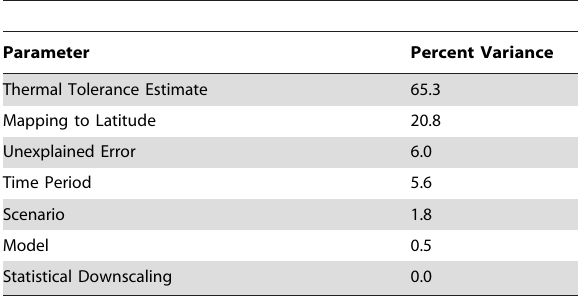
Table 3. Percent variance in estimate of gray snapper northern range attributable to different factors.